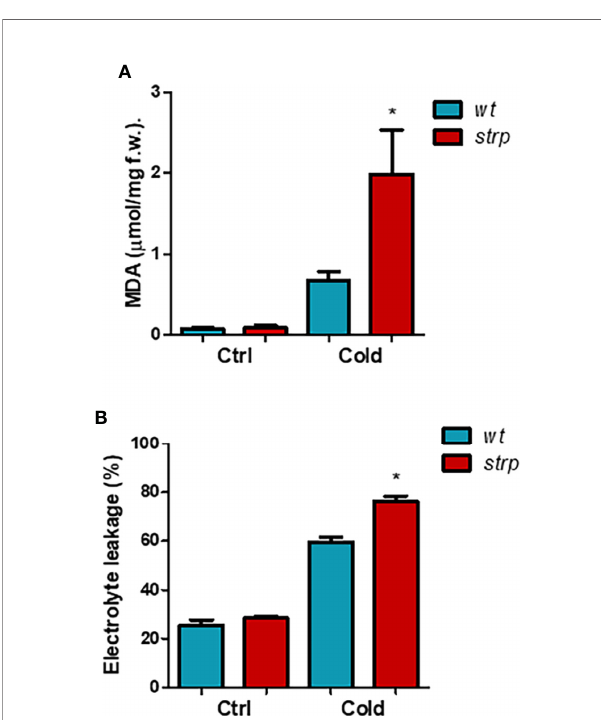
FIGURE 6 | The s trp mutation increases the cold-induced oxidative damages in A. thaliana. Wild type and strp mutant plants were exposed to 4°C for 18 h. Leaves were then used to assay MDA production (Panel A ) and ion leakage (Panel B ). Error bars are S.E.M. of three independent experiments. *P < 0.01, by Student ’ s t-test.